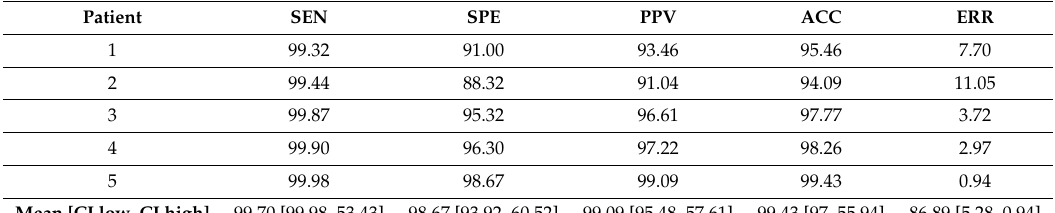
Table 9. Results of the optimized algorithm on 7-day Holter database PREMARIS.